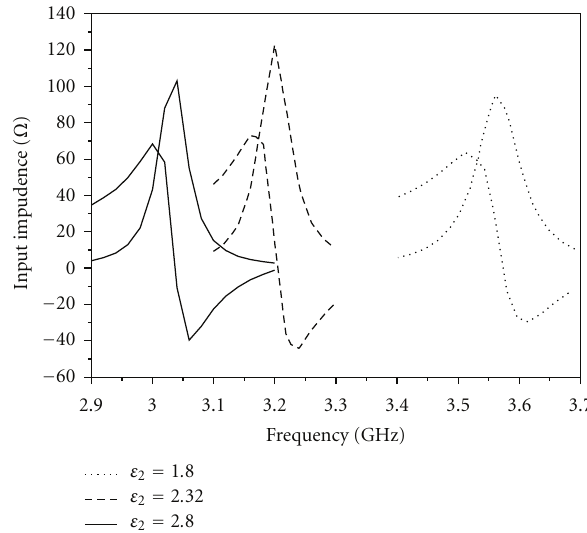
Figure 6: Input impedance of the cylindrical conformal microstrip patch antenna ( ε 1 = 2 . 32, ε 2 = 1 . 8,2 . 32,2 . 8,